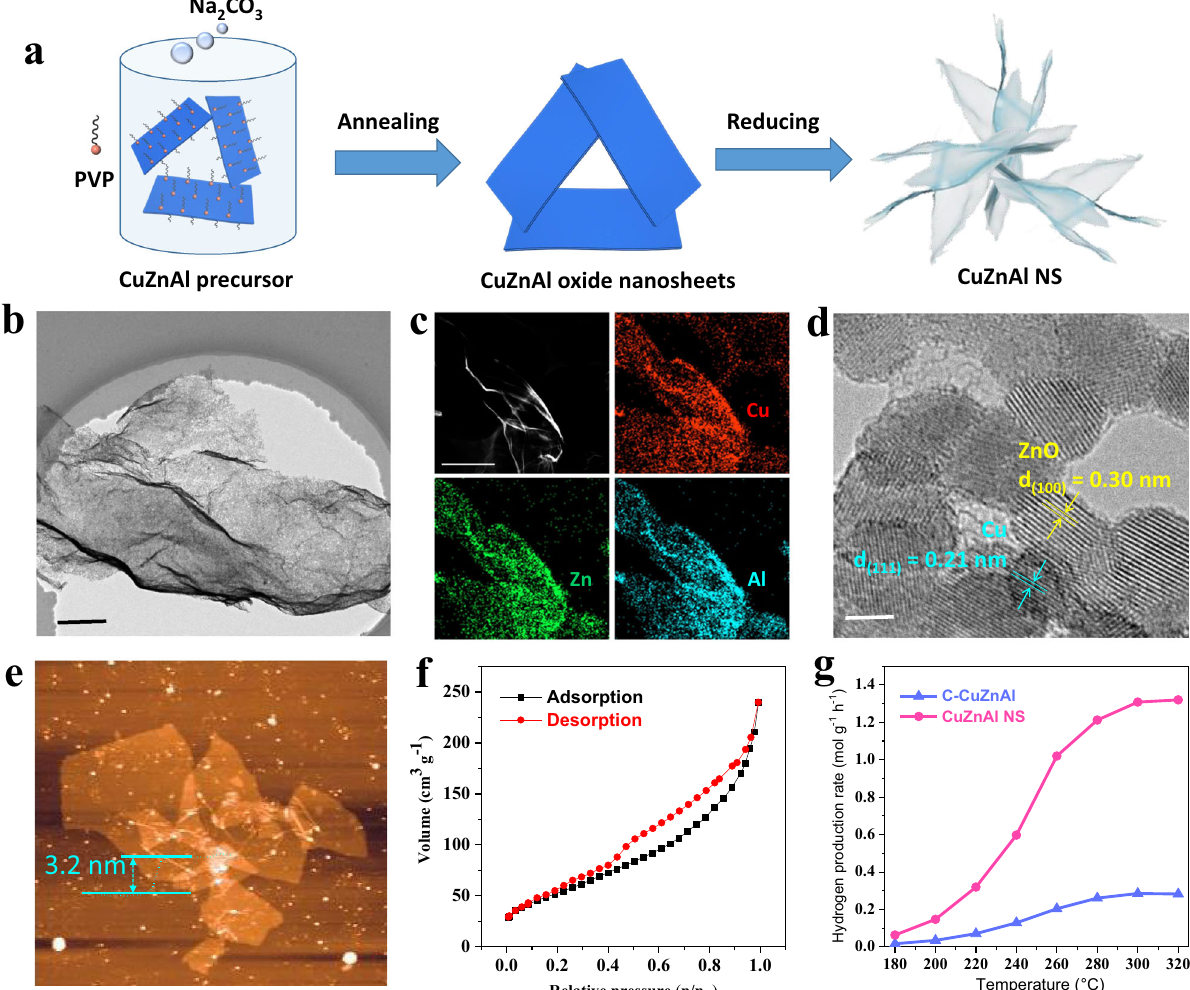
Fig. 4 Preparation and characterization of CuZnAl NS. a Schematic of the synthesis process for CuZnAl NS. TEM image b , elemental mapping image c , HRTEM image d , AFM image e , and nitrogen adsorption and desorption isotherm f of CuZnAl NS. g Hydrogen production rate from the MSR of CuZnAl NS and C-CuZnAl at different temperatures. Test conditions: 10 mg of catalyst, 50 sccm of Ar, and 0.1 sccm of methanol (the volume ratio of methanol to water = 1:1.3). The scale bars in b , c , and d are 200, 500, and 2 nm, respectively. CuZnAl NS and C-CuZnAl are abbreviations for CuZnAl nanosheets and commercial CuZnAl,